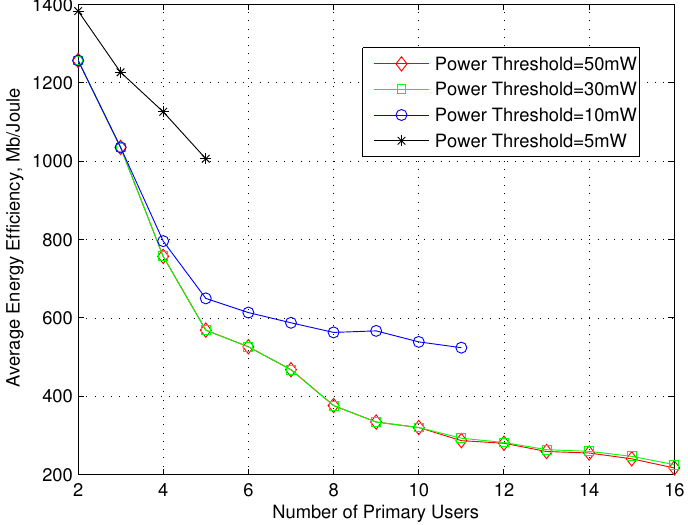
Figure 5. The variation of average energy efficiency with number of primary users for different power